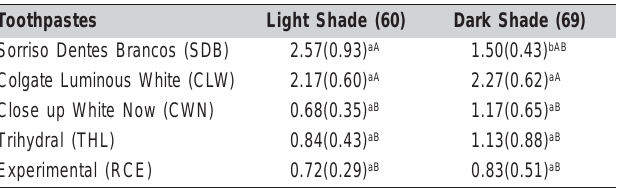
Table 2. Means (standard deviation) of color stability ( ∆ E) of artificial teeth (light and dark) subjected to mechanical brushing with different toothpastes (2-way ANOVA, Bonferroni test, p<0.05).